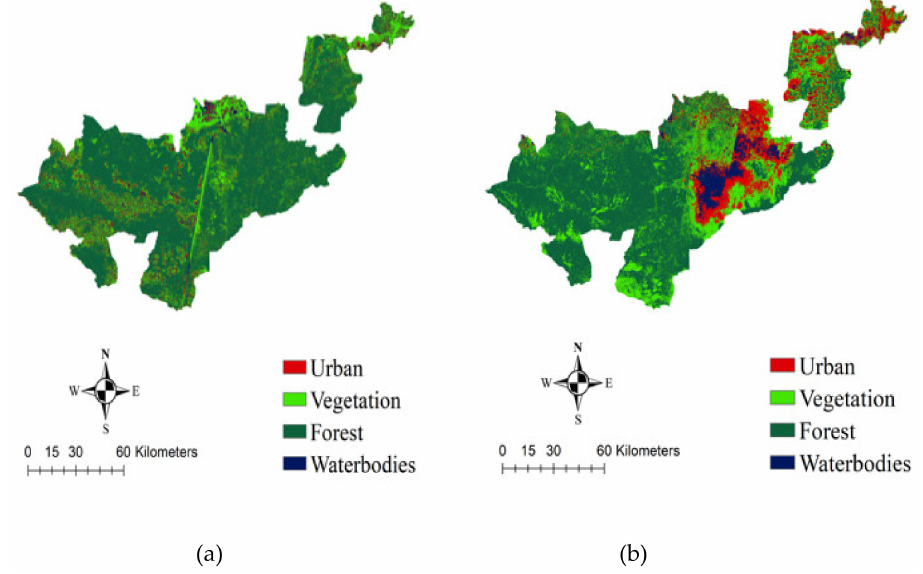
Figure 6. Change detection in the LULC for classified forest areas in South Sumatra. ( a ) LULC, 2003; and ( b ) LULC,